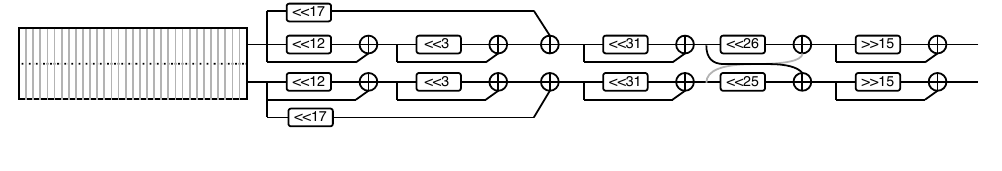
Figure 7: Clyde-128 and Shadow-512 L-box.